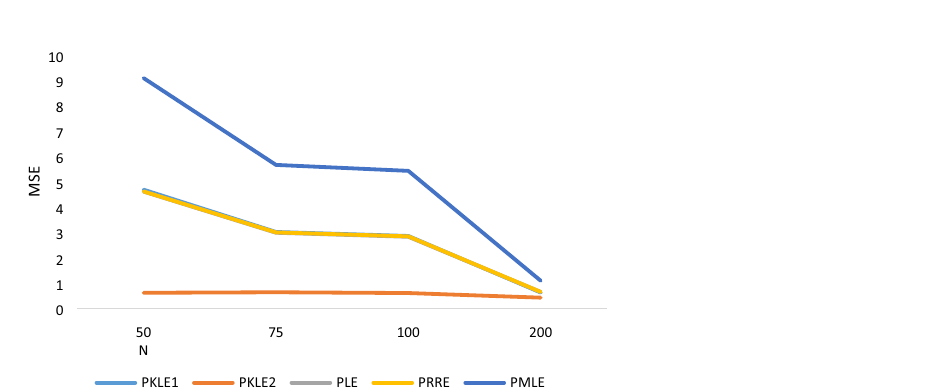
Figure 3. Intercept = 0; ρ = 0.999; p =